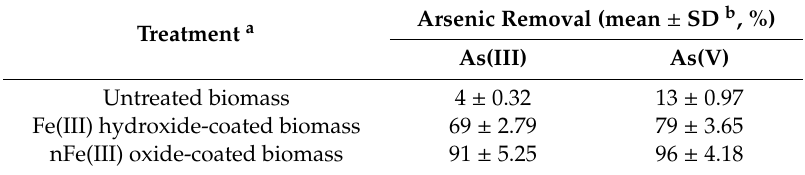
Table 2. Arsenic removal (%) by untreated biomass, Fe(III) hydroxide-coated biomass, and Fe(III) oxide-coated